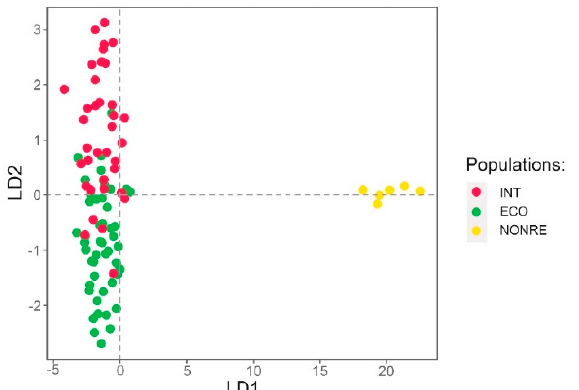
Figure 6. Discriminant analysis of principal components (DAPC) based on 4879 SNPs. Color and sign code: red, populations from integrated orchards (INT); green, populations from organic orchards (ECO); yellow, laboratory population (NONRE).